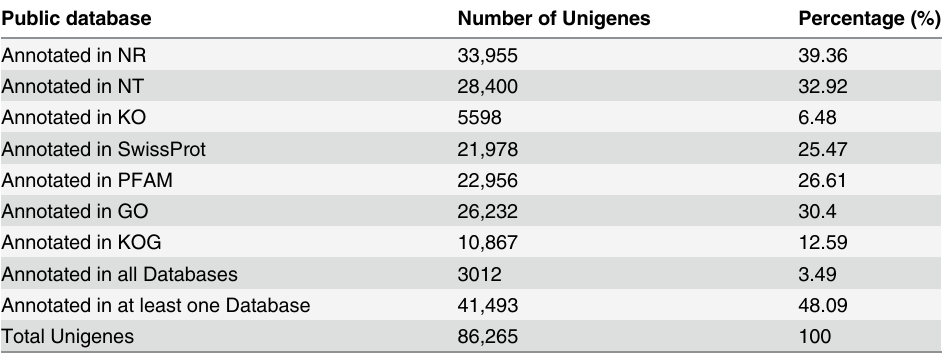
Table 2. Summary of functional annotation of assembled